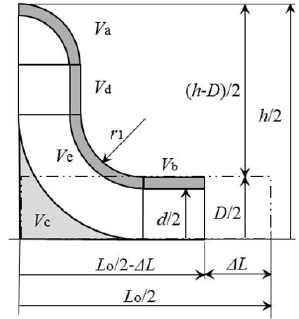
Figure 25. Relationship between bulge height and amount of axial feeding for T ‐ shape and cross ‐ shape hydroforming (C1220, experiment).